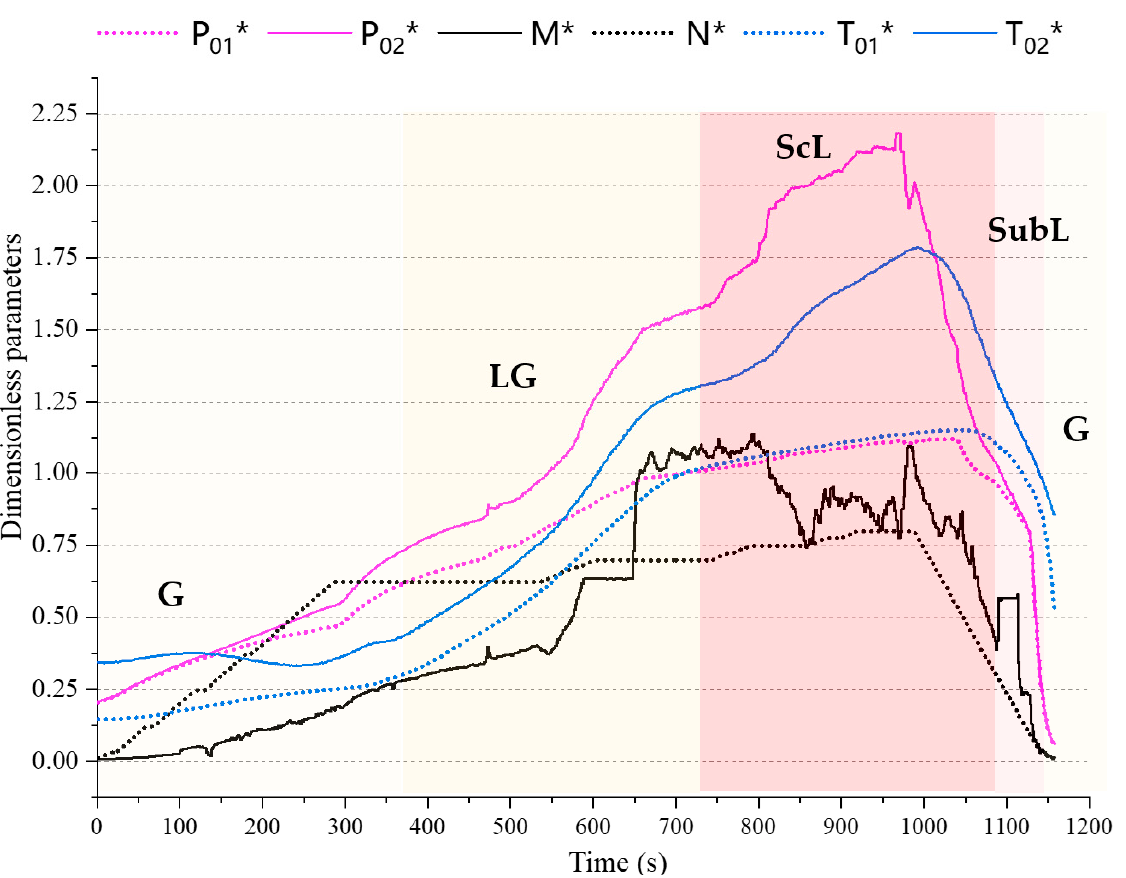
Figure 9. Original experimental data and historical curves.